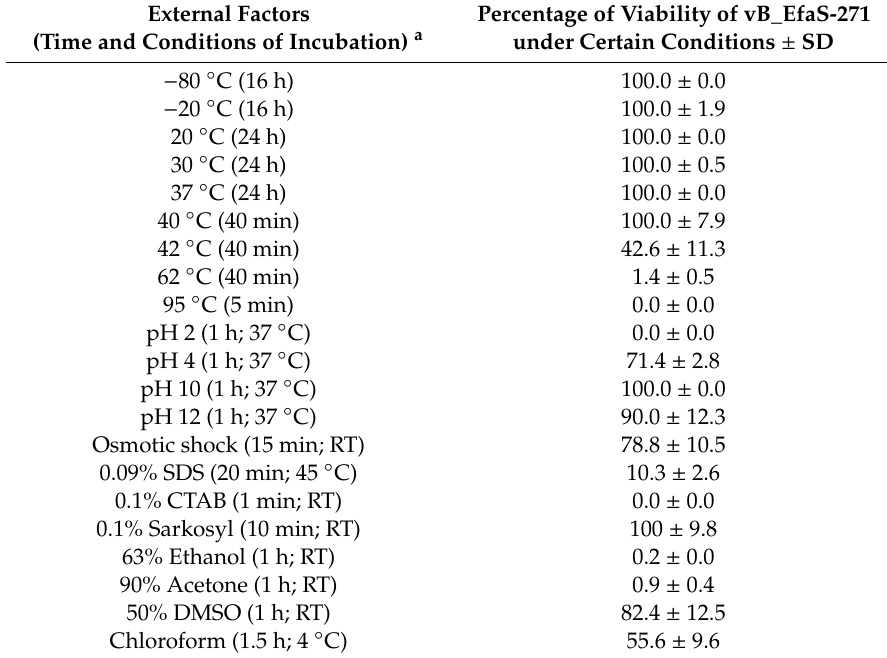
Table 3. Sensitivity of vB_EfaS-271 virions to external physical and chemical agents. External